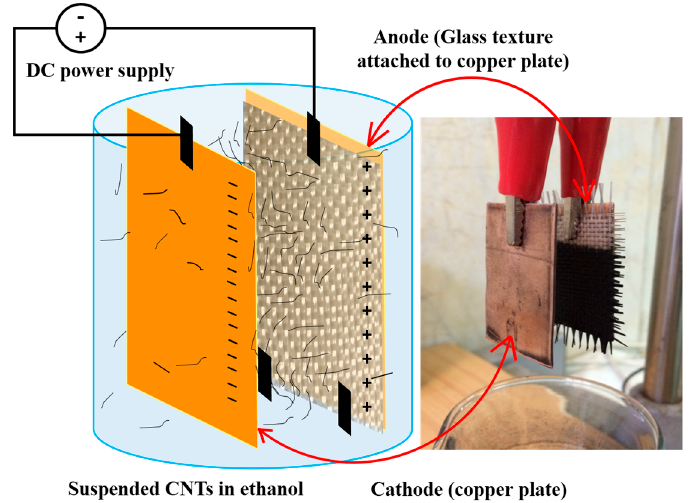
Figure 1. Glass fiber texture (GT) arrangement in suspension during the EPD process.